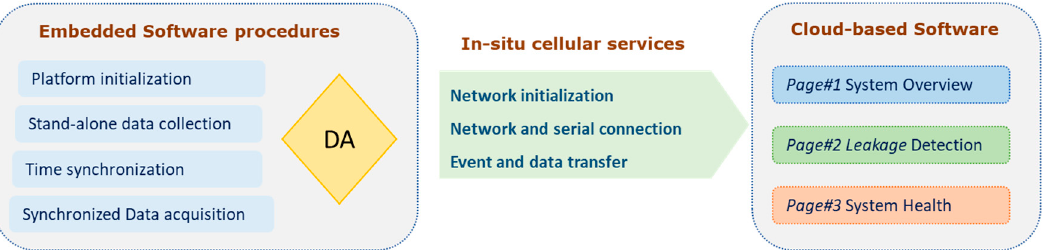
Figure 4. ESTHISIS Software